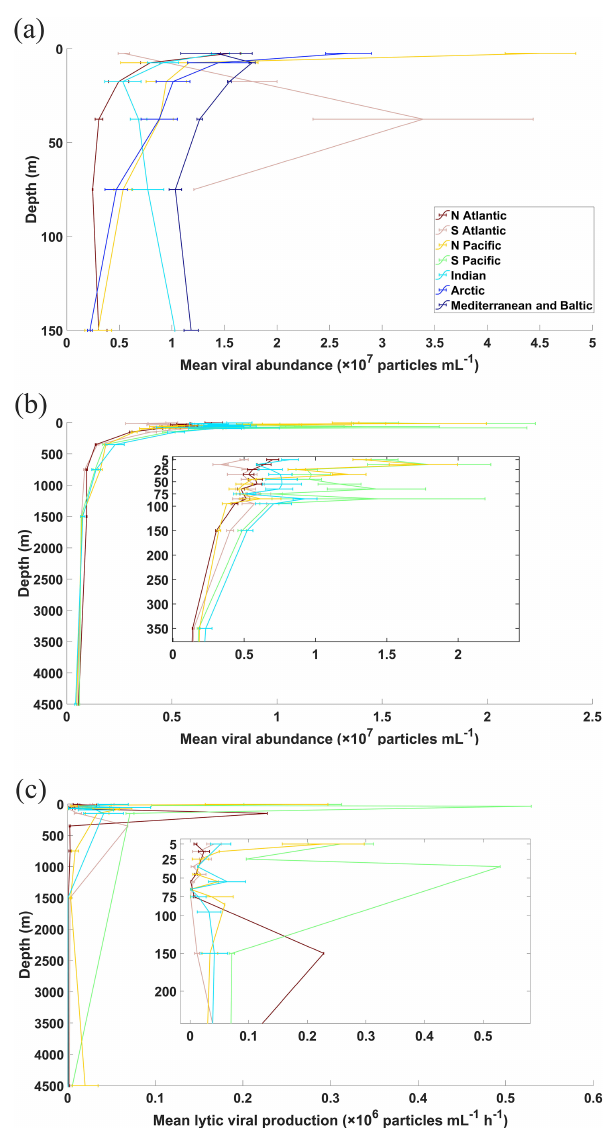
Figure 7. Vertical profiles of average viral abundance of each ocean basin in (a) coastal and (b) open-ocean waters. Also shown are the vertical profiles for open-water lytic viral production (c) , while those for coastal samples were not constructed because of limited data points. Error bars represent 1 standard error of the